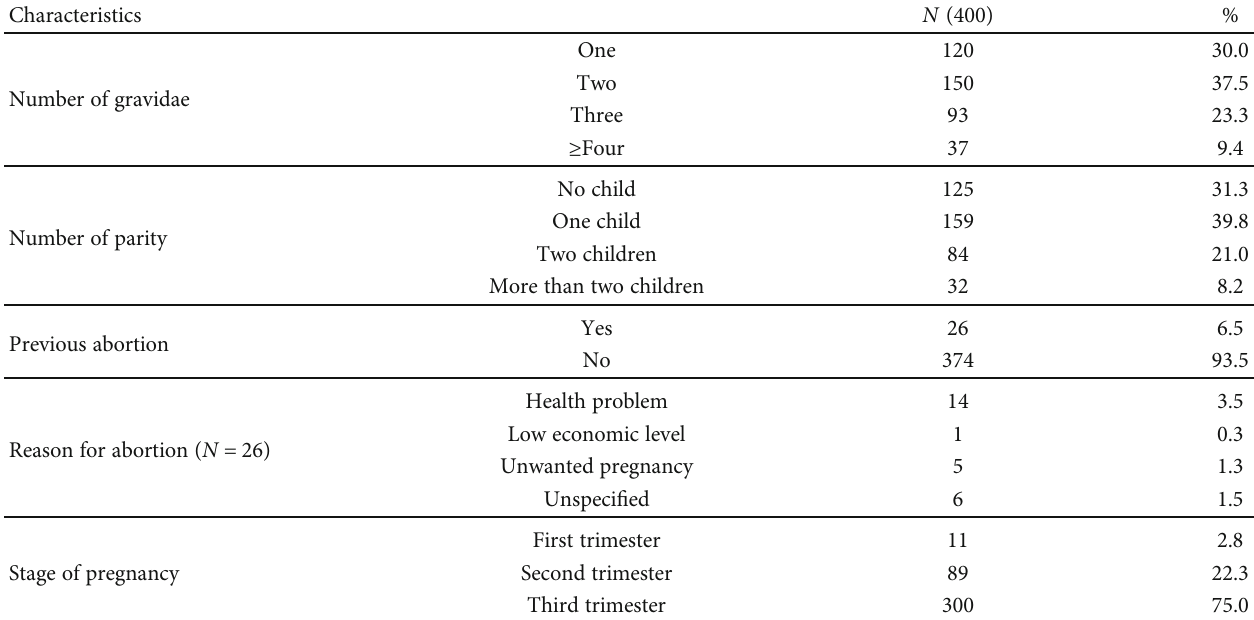
Table 2: Obstetrics information of the respondents at UoGCSH, June 2019.